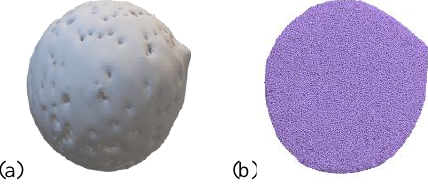
Fig. 9. Single particle model of LWCA: (a). X-ray tomography model; (b). DEM